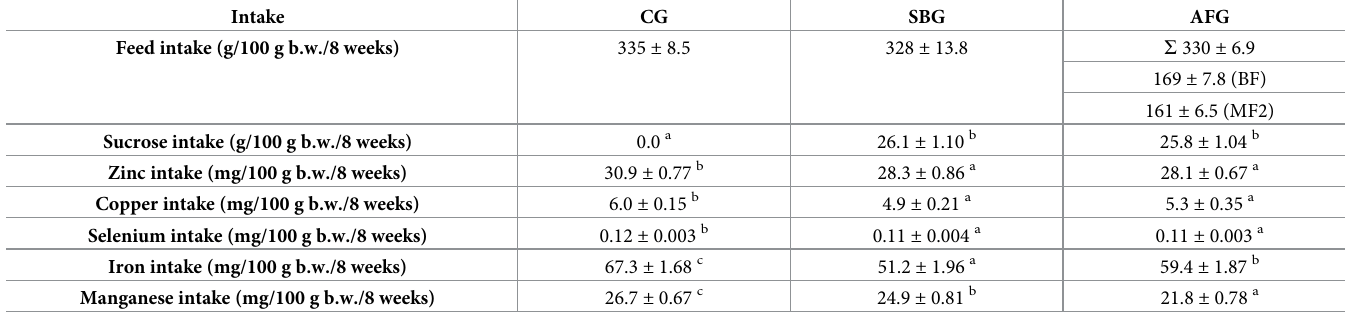
CG—Control Group, SBG—Sucrose Balanced Group, AFG—Alternately Fed Group a,b,c -Means marked with different letters in the same line are statistically different, p � 0.05.